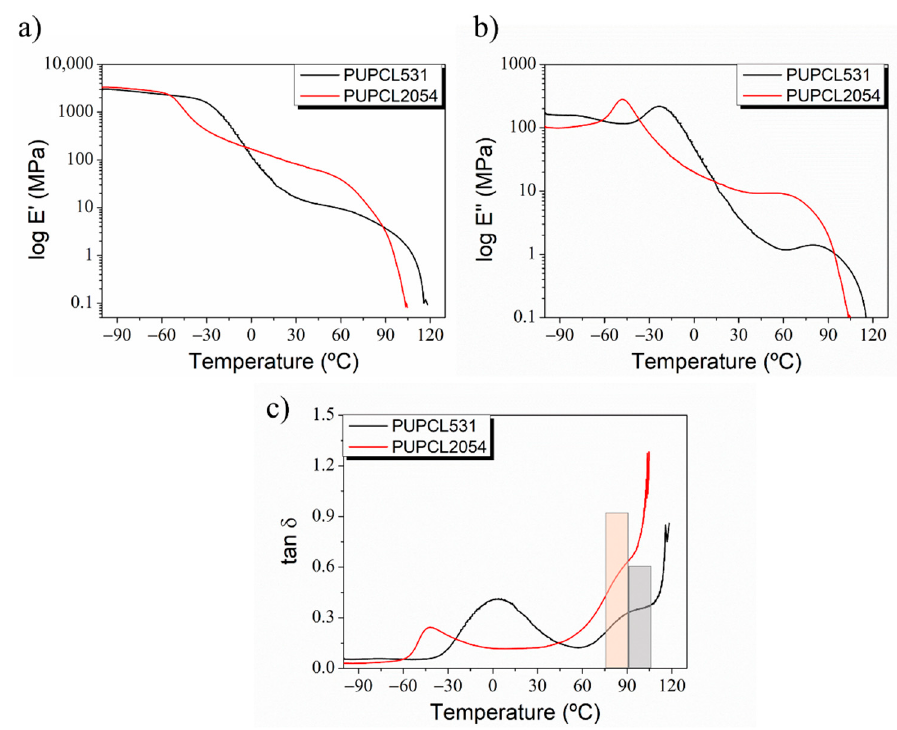
Figure 4. Dynamic mechanical thermal analysis: ( a ) storage modulus, ( b ) loss modulus and ( c ) tan δ for both samples.